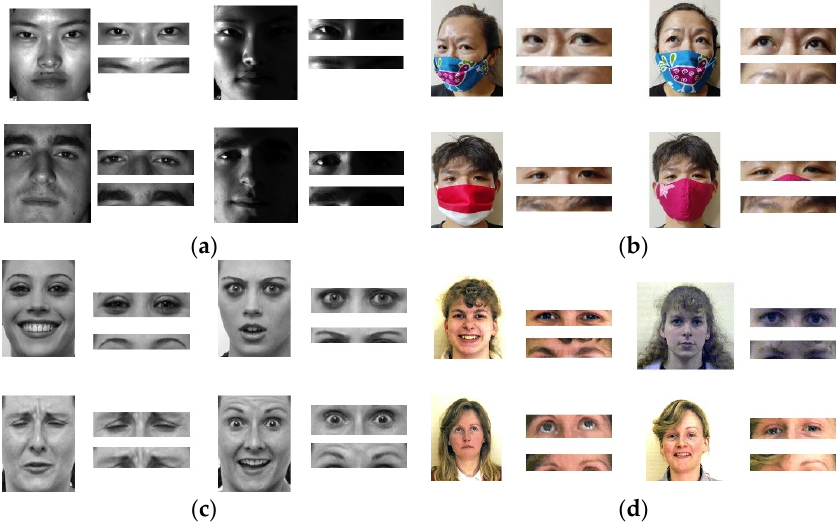
Figure 10. Examples of images according to the order of the datasets from controlled to uncontrolled conditions: ( a ) EYB dataset, ( b ) RFFMDS v1.0, ( c ) PES dataset, and ( d ) ABD.